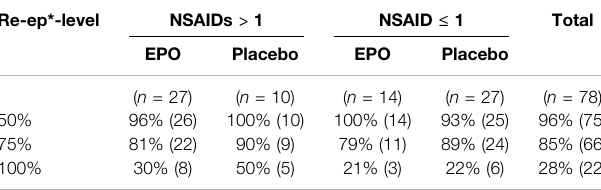
TABLE 10| Likelihood ofachieving the designated re-epithelialization levels within the observation period by subgroup stratum.